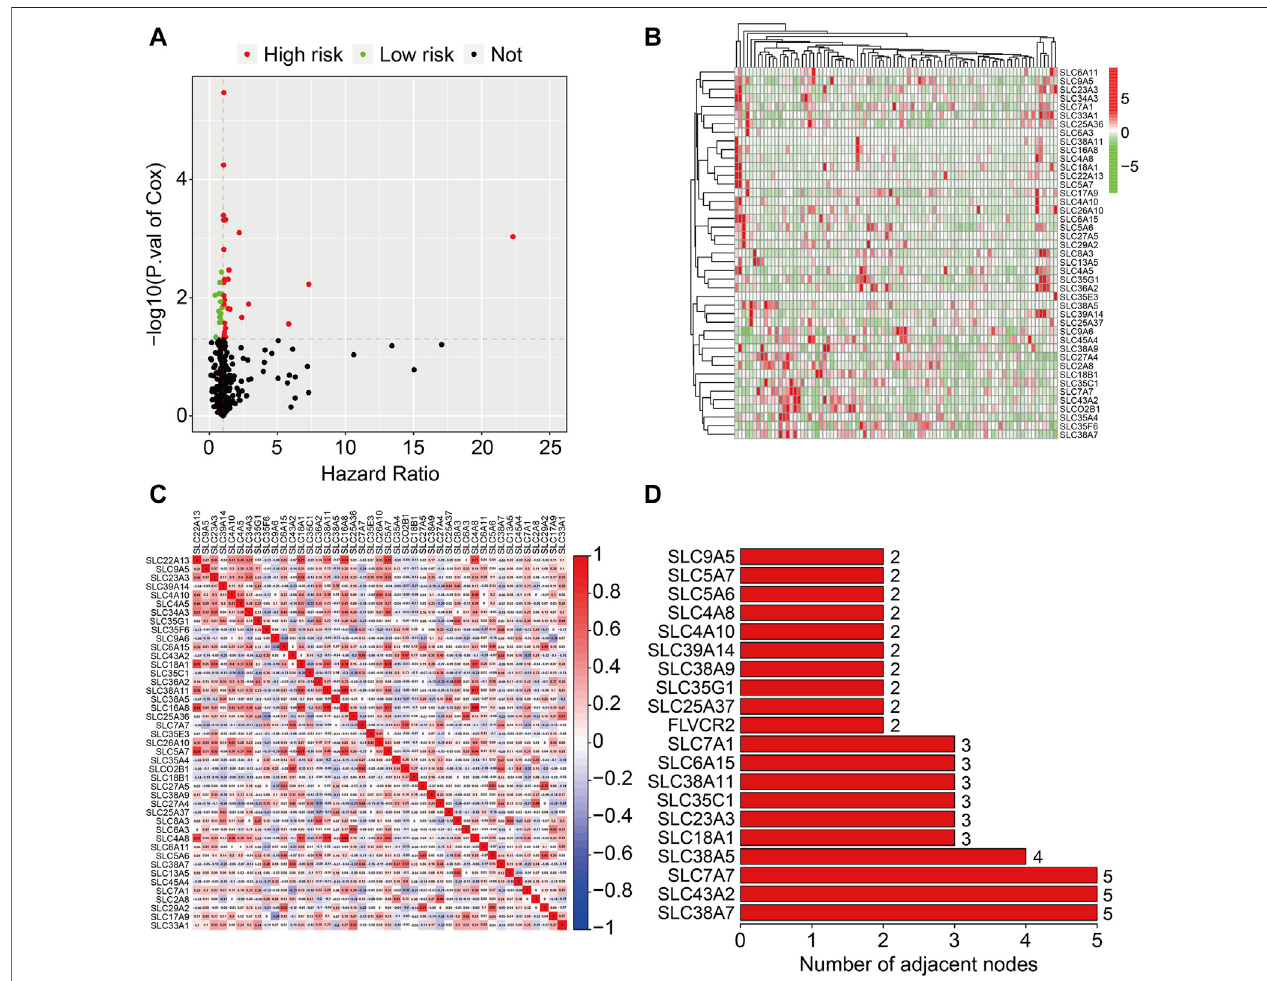
FIGURE1| Identi fi cationofprognosis-relatedSLCfamilygenesinosteosarcoma. (A) Volcanoplotpresentedprognosis-related genesofSLCfamily. (B) Heatmap depicted the expression patterns of prognosis-related SLC family genes in dataset from the TCGA database. (C) The correlation heatmap of the prognosis-related SLC family genes. (D) The bar chart displayed the number of adjacent nodes in PPI network.